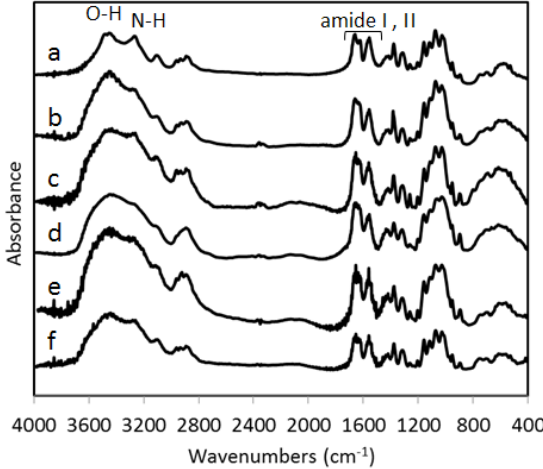
Figure 5. X-ray diffraction profiles of ( a ) commercially available chitin, and